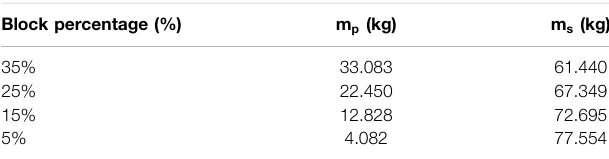
TABLE 1 | Mass of phyllite blocks and sand matrix with different blocks percentage. Block percentage (%)